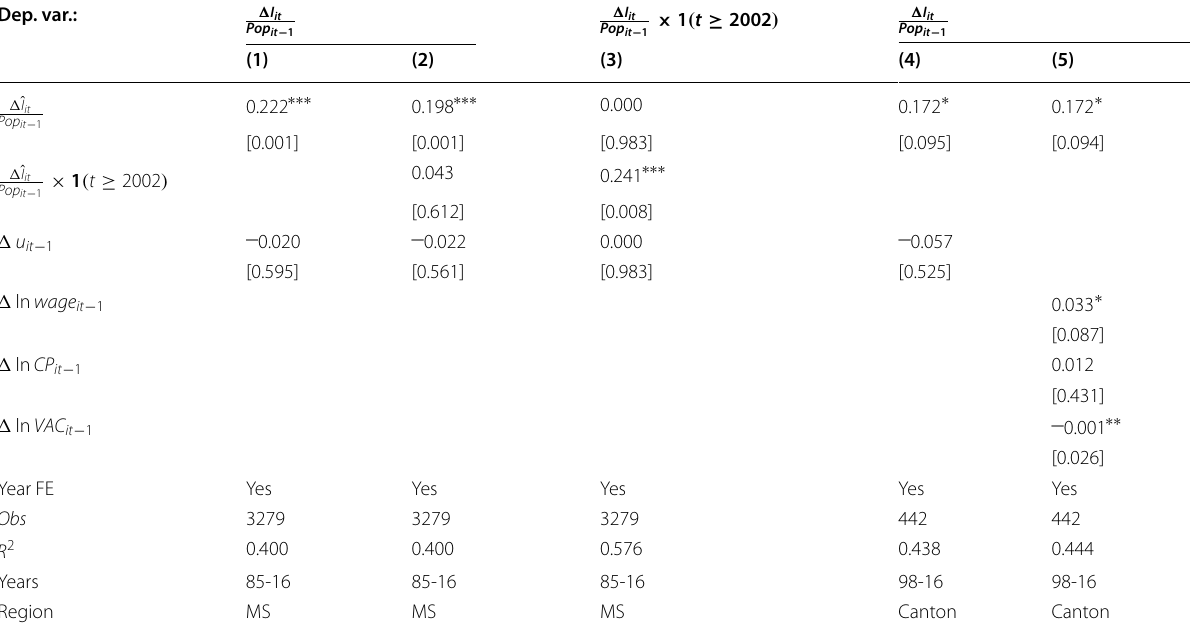
p -values in brackets. In columns 1–3, standard errors are clustered by MS-regions. In columns 4–5, standard errors are clustered by cantons and estimated by the wild bootstrap. (cid:31) indicates first differences. The settlement pattern of immigrants in 1980 is used to predict the stock of foreigners in each region and year Significance levels: ∗ p < 0.10 , ∗∗ p < 0.05 , ∗∗∗ p < 0.01